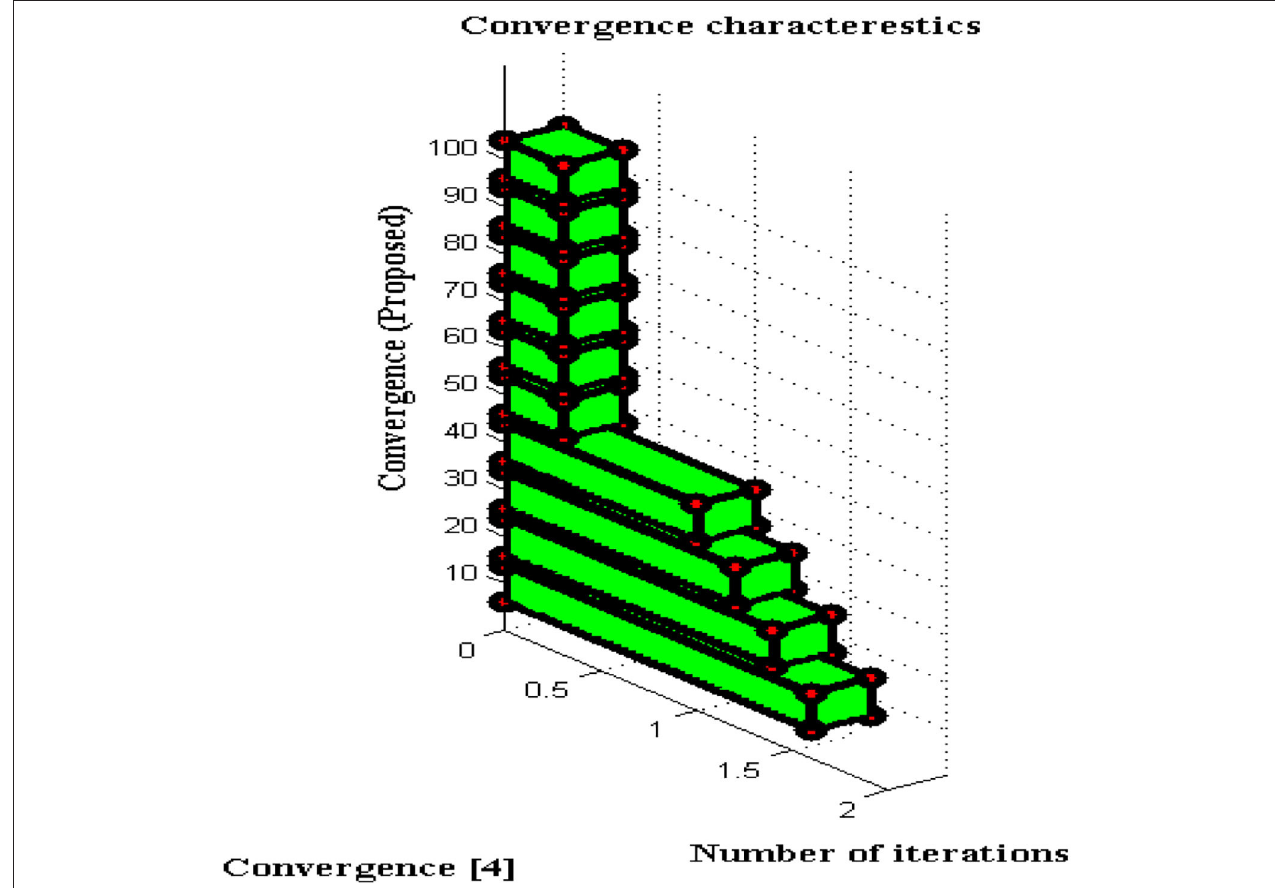
FIGURE 9 | Convergence